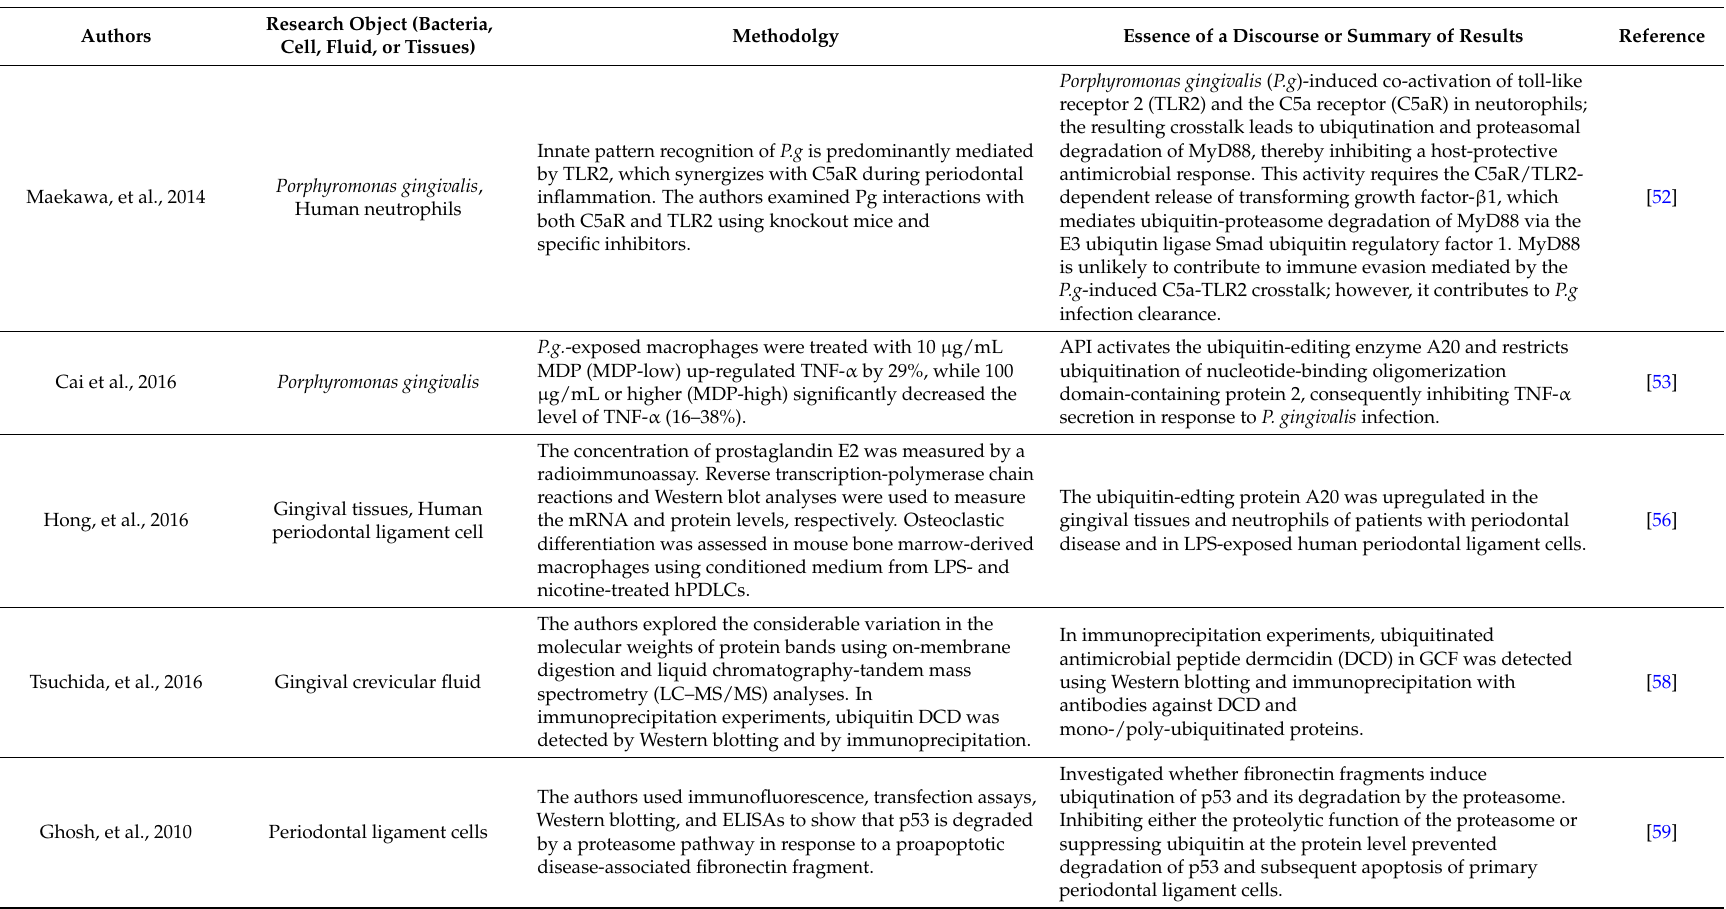
Table 1. Summary of studies on ubiqutin in periodontal